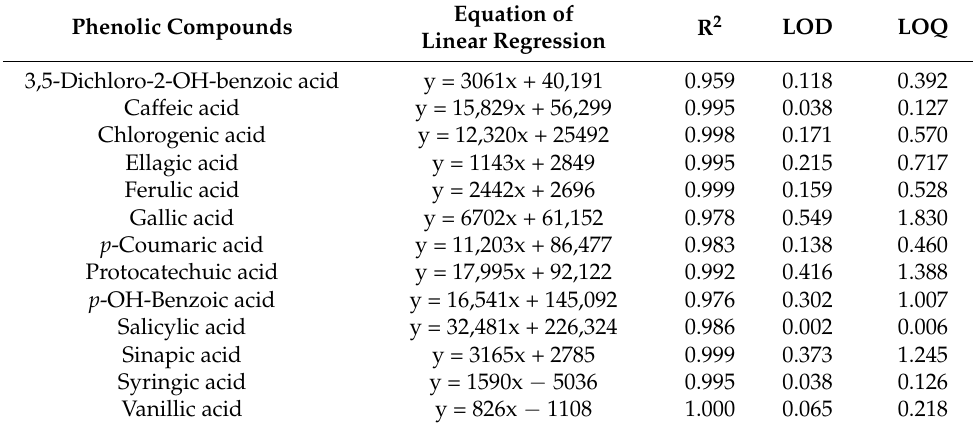
Table 8. The calibration parameters of phenolic acids using rate of peak normalizations, with their determination coefficient, LOD, and LOQ